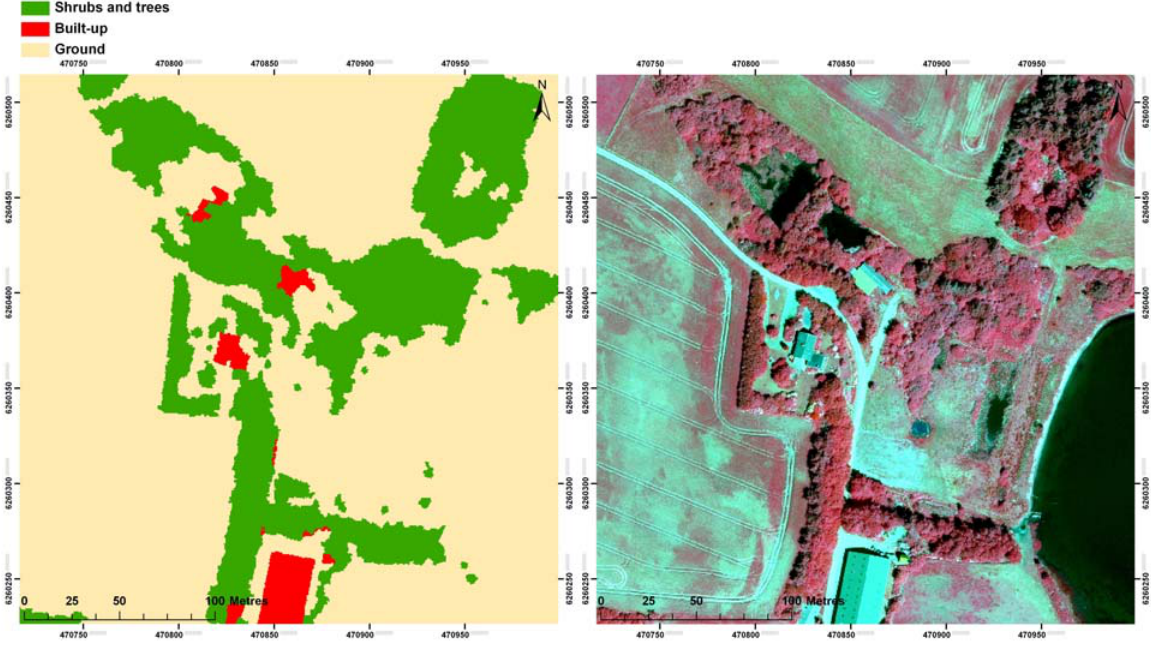
Figure 13. This example (1) shows how the combination of the nDSM, the CIR orthoimages, and the SUM/NIR feature has effectively classified and separated shrubs and trees, as well as